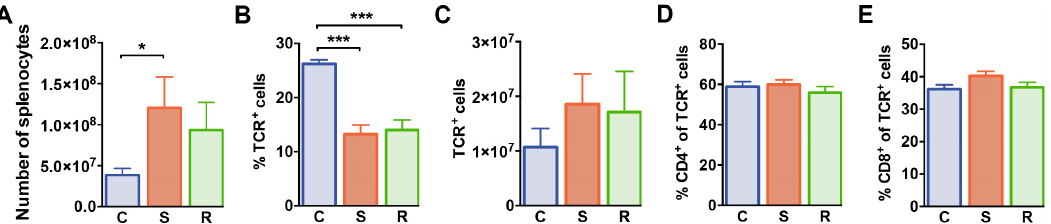
Figure 3. Numbers of splenocytes and αβ T cells in mice after social defeat and control animals. ( A ) Absolute numbers of splenocytes in control, susceptible and resilient mice. ( B ) Percentages and ( C ) numbers of TCR + T cells, ( D ) percentages of CD4 + cells among TCR + T cells, and ( E ) percentages of CD8 + cells among TCR + T cells in the spleen as determined by flow cytometry. Bar graphs represent